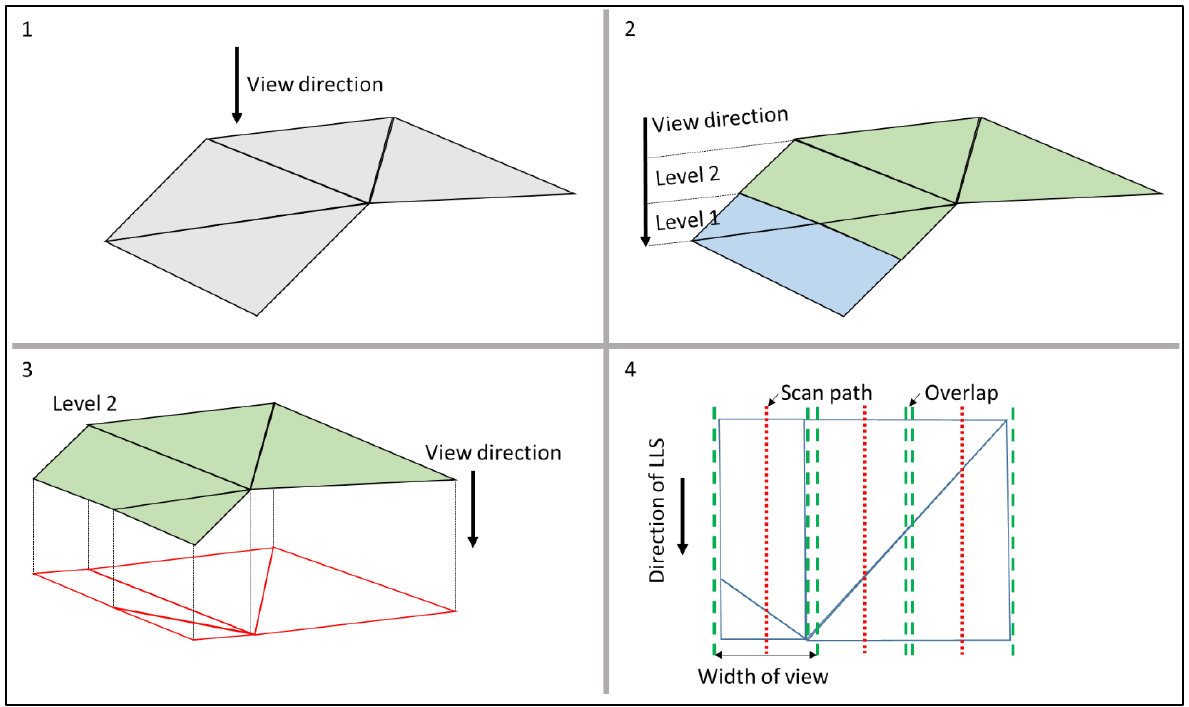
Figure 7. Determination of scan paths for a specific view direction. ( 1 ) Select total surface for a specific view direction. ( 2 ) Divide surface in different scan depths. ( 3 ) Projection of each scan depth on to plane. ( 4 ) Determination of scan paths.